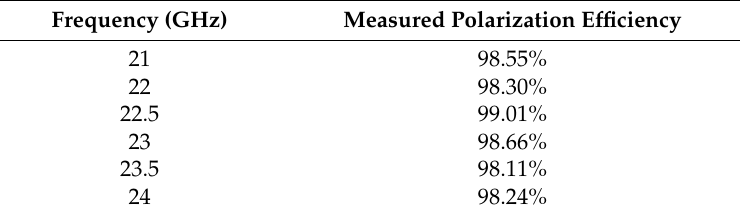
Figure 18. Comparison between measured and simulated radiation efficiency of the three-way divider antenna system. Table 2. Measured polarization efficiency vs. frequency.